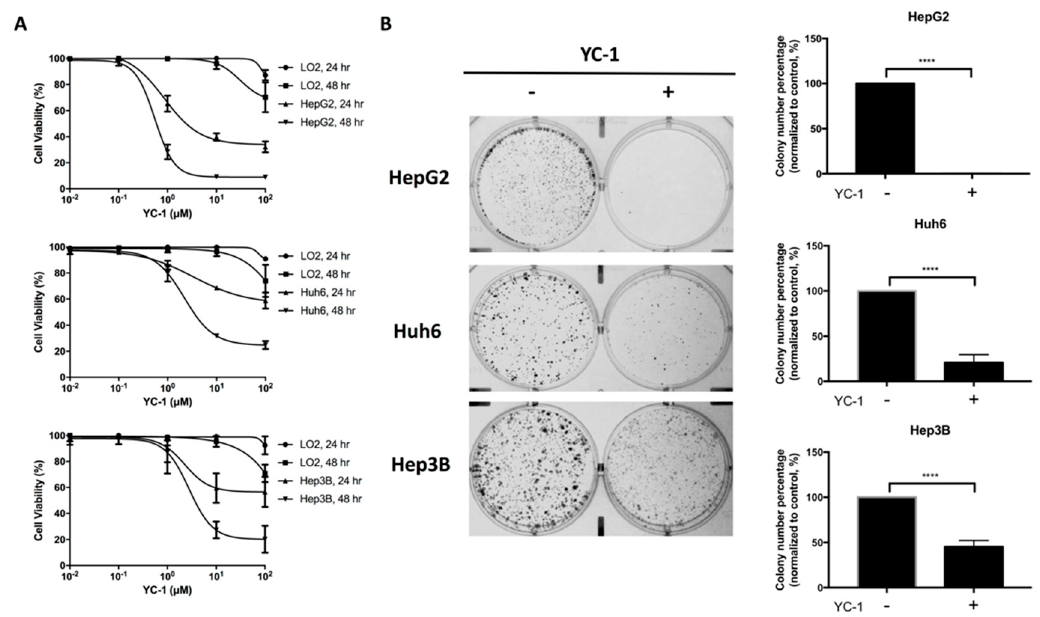
Figure 1. YC-1 suppressed hepatocellular carcinoma (HCC) cell proliferation in a dose- and time-dependent manner. HCC cells were exposed to serial dilutions of YC-1 ranging from 0.01 to 100 µ M. After 24 and 48 h, the viability of HepG2, Huh6, and Hep3B cells was measured by an MTS assay ( A ). The e ff ect of YC-1 on the cell colony formation was assessed by a clonogenic assay. HCC cells were treated with dimethyl sulfoxide (DMSO) or with the IC 50 of YC-1 for 24 h, and the medium was then replaced with complete medium. After 10 days, colonies were fixed and stained ( B ). The error bars indicate the standard error of mean (SEMs) of data obtained in at least three independent experiments. **** p < 0.0001.